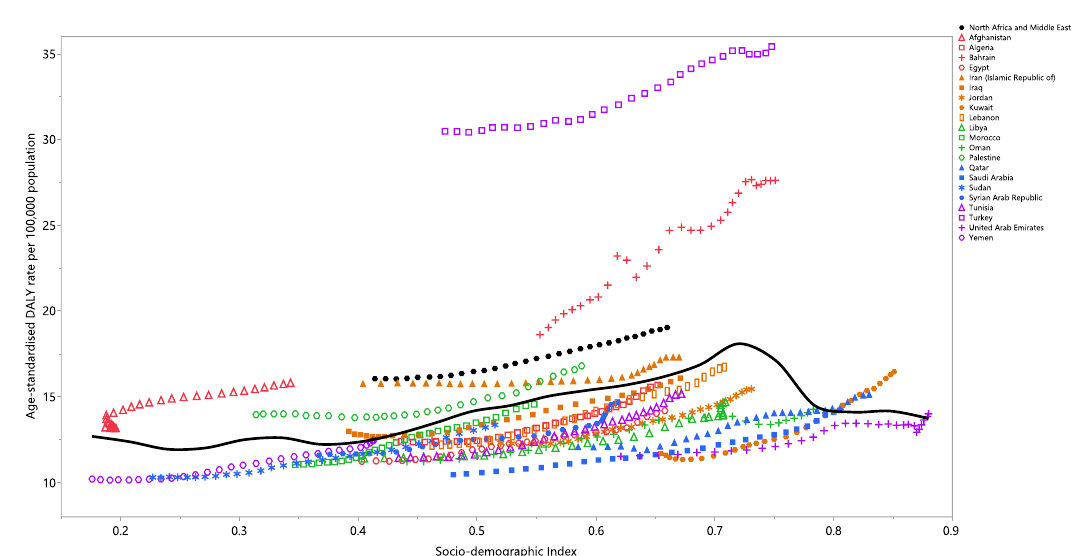
Figure 3. Ratio of the Middle East and North Africa region to global rheumatoid arthritis DALY rate according to age group and sex, 1990–2019. DALY disability-adjusted-life-years. MENA Middle East and North Africa. (Generated from data available from http:// ghdx. healt hdata. org/ gbd- resul ts- tool).